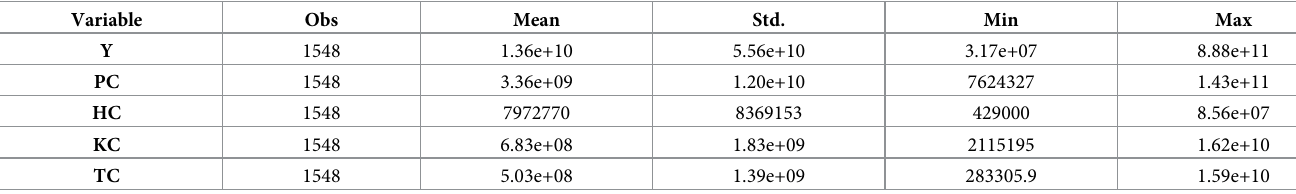
Table 3. Descriptive statistical results of variables (unit: yuan). Variable Obs